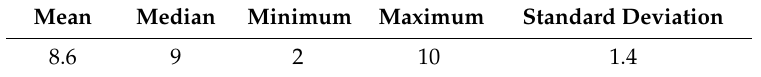
Table 6. Study of the level of satisfaction with the participation in the 6th Poznan Half